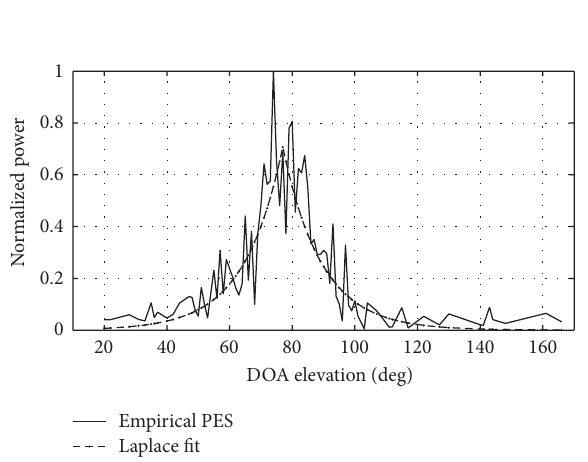
Figure 11: Empirical APES and its Laplace fit.